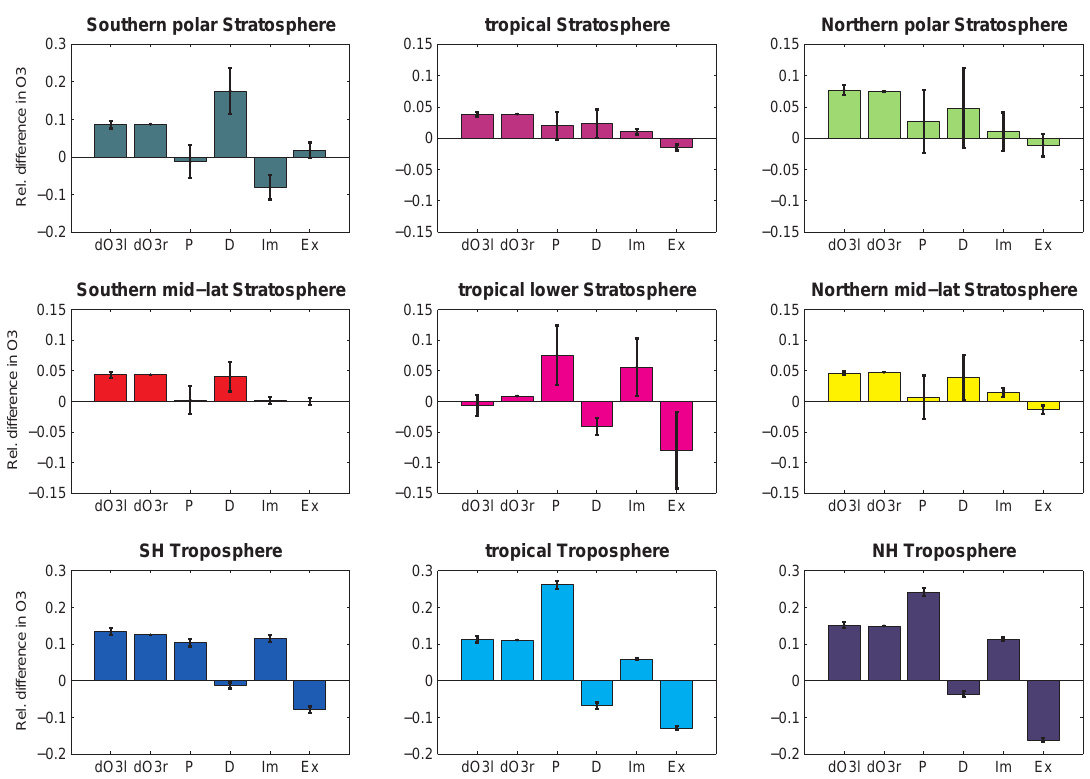
Fig. 10. Relative differences 2040s - 2000s in mean ozone mixing ratios (( O p 2 3 − O p 1 3 ) /O p 1 3 ) of each region. The first bar and the second bar are the differences calculated from the left and right hand side of Eq. (5). The other bars are changes in ozone over this period due to changes in chemistry (production [ P ] and destruction rates [ D ] ) and dynamics (import Im and export Ex ). The errorbars denote the 1 sigma uncertainty in the differences.